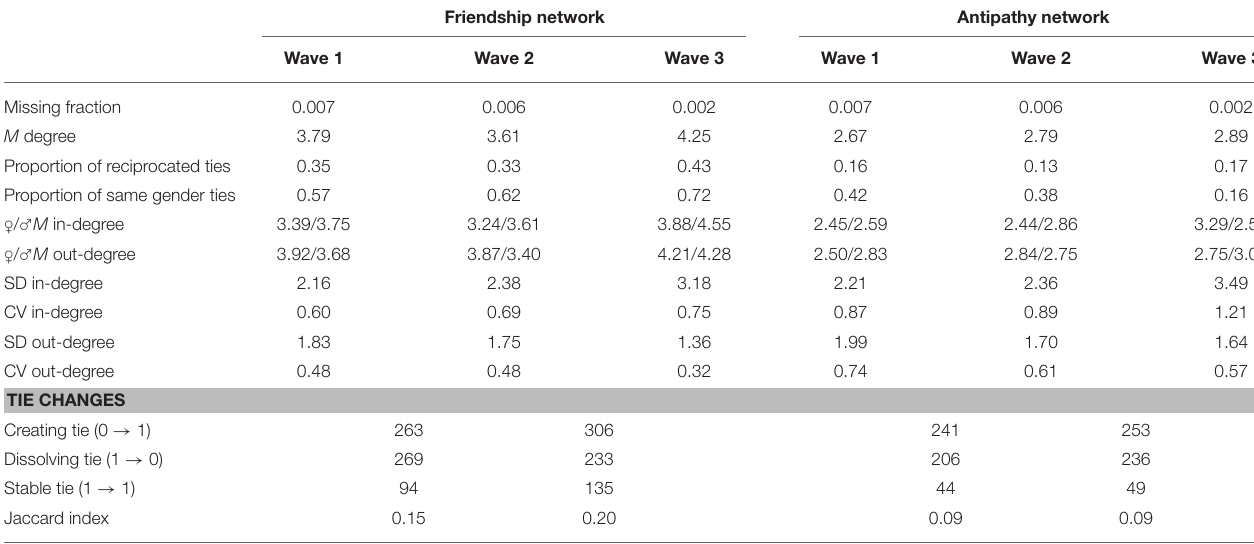
TABLE 3 | Descriptive statistics of friendship and antipathy networks.